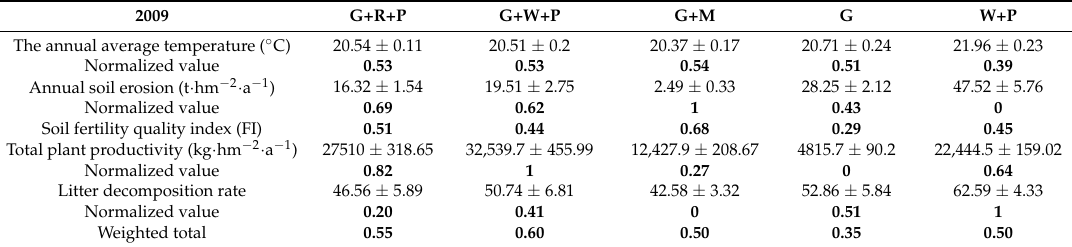
Table 4. Ecological indicators in three mixed Ginkgo systems, pure Ginkgo (G), and a cropping system (W+P), in 2009.